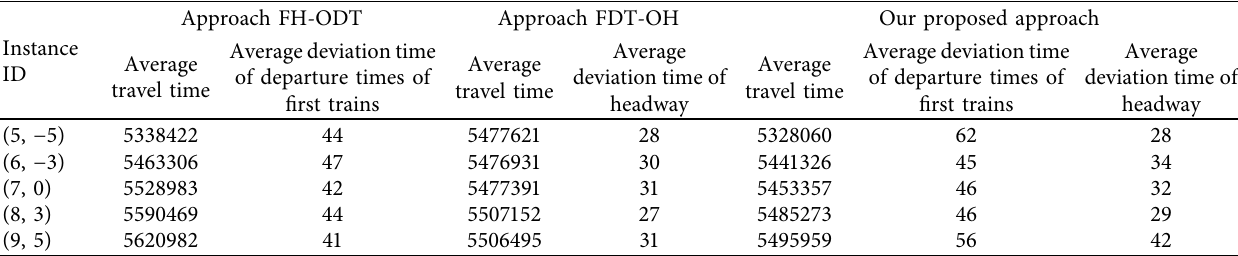
Table 15: Influence of decision variables on